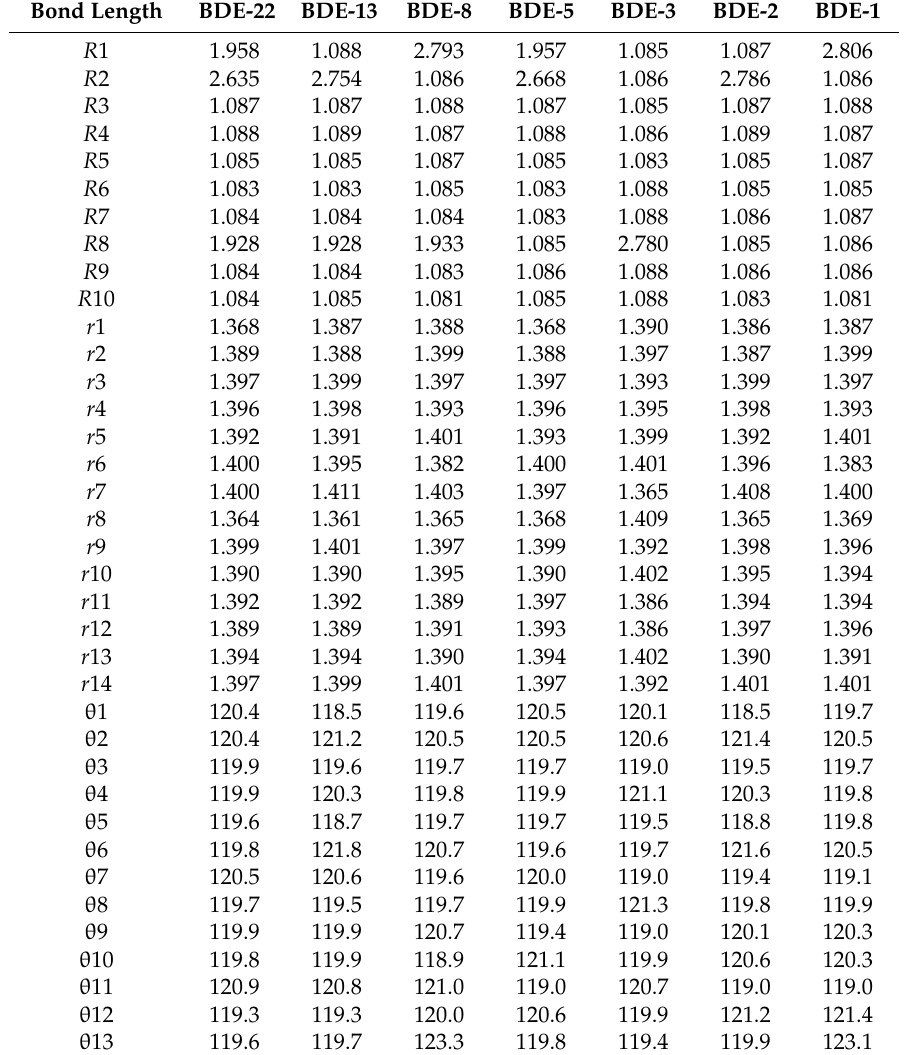
Table 5. The structural parameters of the selected anionic PBDEs calculated at the B3LYP/6-311+G(d) level [ R (Å), r (Å), and θ (deg)].